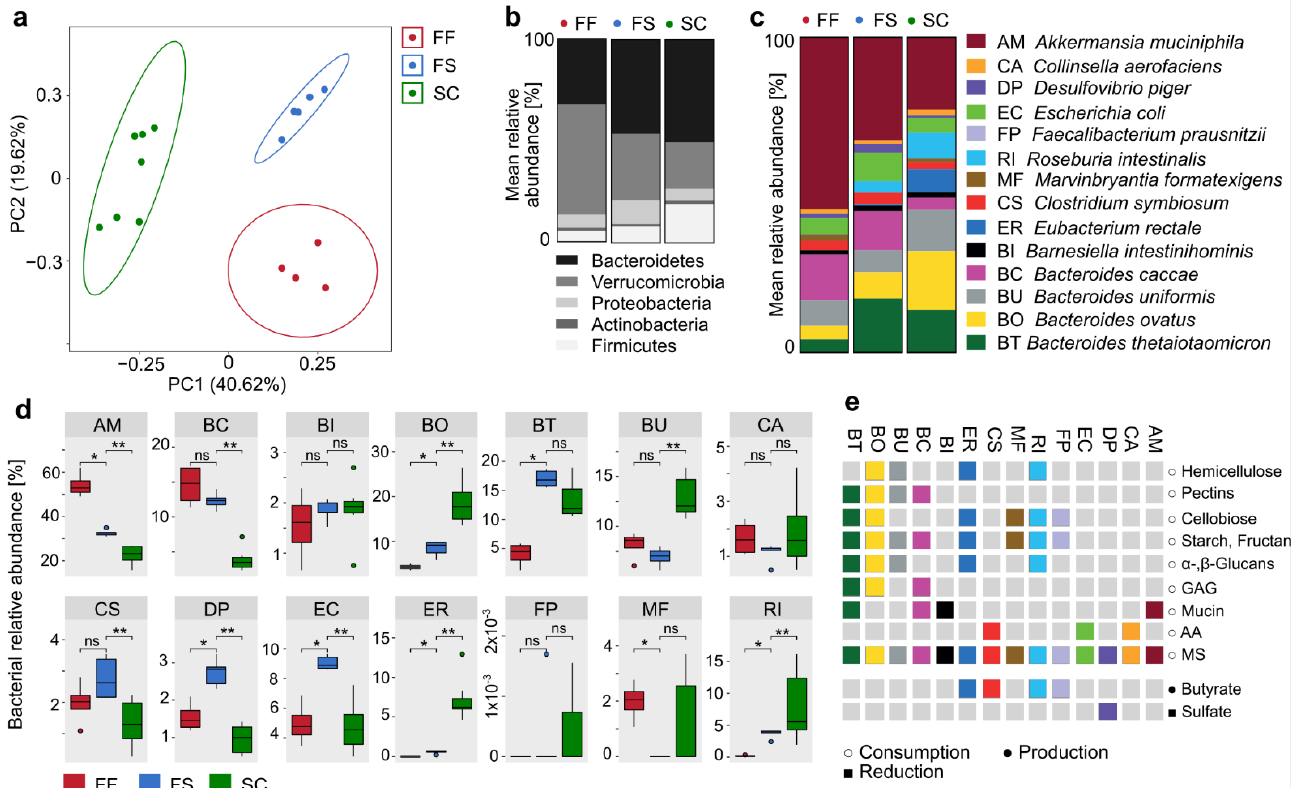
Figure 2. Compositional changes within a synthetic microbiota in response to dietary fiber supplementation. ( a ) PCA plot of the microbiota composition as calculated with the “prcomp” function within the R package “stats”, using 16S rRNA gene sequencing data from fecal samples and based on a Euclidian distance matrix. ( b ) Mean relative abundances of the 14SM microbial community on a phylum level. ( c ) Left panel: Mean relative abundance of each constituent strain of the 14SM community in mice fed either FF, FS or a SC diet. Right panel: Names of the 14SM-constituent strains and their two-letter abbreviations. ( d ) Tukey boxplots of the relative abundance of each strain; outliers shown as circles; statistics: Wilcoxon rank sum test performed with the “compare_means” function within the R package “ggpubr”; *: p < 0.05, **: p < 0.01. ( e ) Metabolic characteristics of each strain as determined in detail previously [6]; colored boxes represent metabolic activity related to the indicated substances; grey boxes represent no metabolic activity. GAG = glucosaminoglycans, AA = amino acids, MS = monosaccharides. AM: A. muciniphila , BC: B. caccae , BI: B. intestinihominis , BO: B. ovatus , BT: B. thetaiotaomicron ,